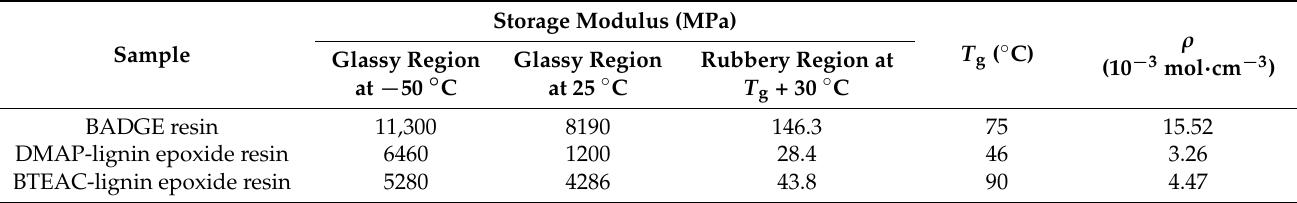
Table 6. Dynamic mechanical properties and crosslink density ( ρ ) of the DMAP-lignin epoxide resin, BTEAC-lignin epoxide resin, and BADGE resin.